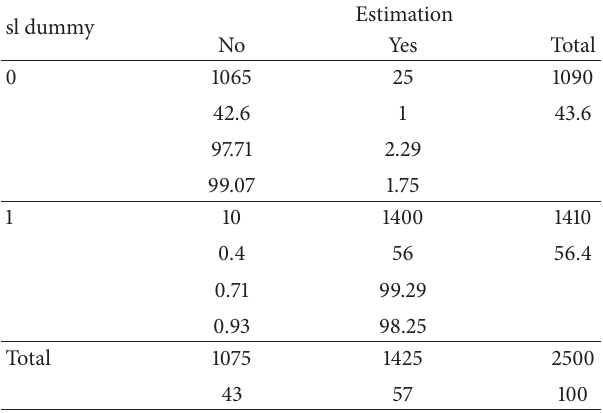
Table 7: Sampling level dummy by